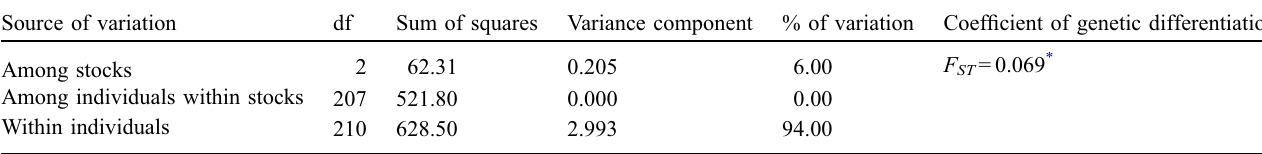
Table 4. Analysis of molecular variance of Sperata aor stocks delineated from the river Ganga. Source of variation df Sum of squares Variance